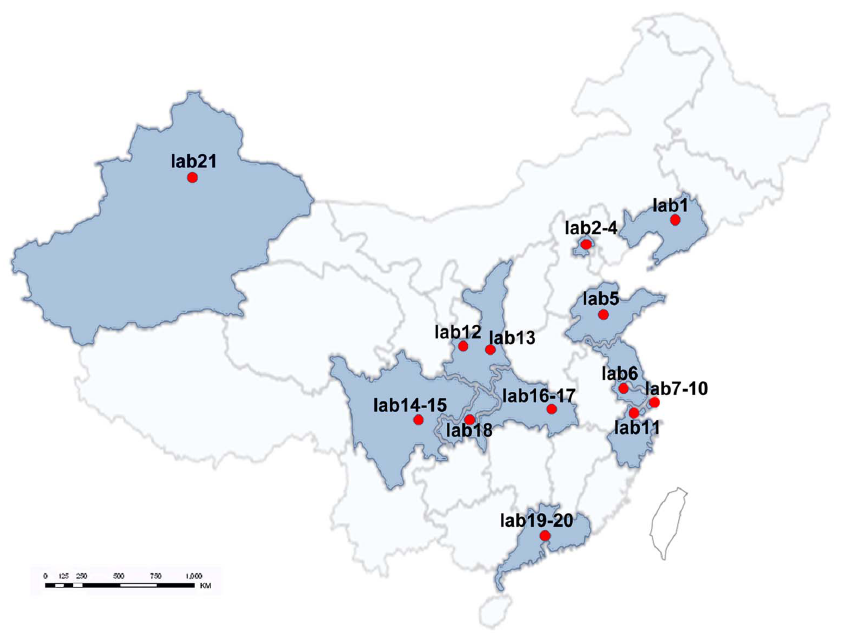
Figure 3. Map of 21 laboratories in China selected to perform reference interval validation.